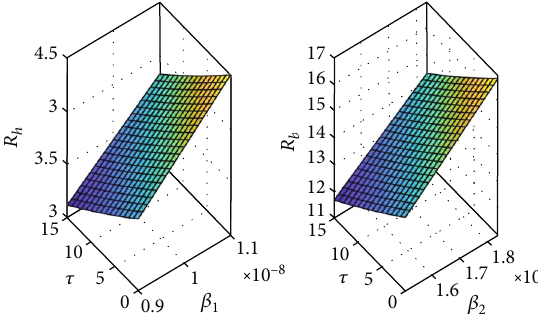
Figure 1: HIV and HBV basic reproduction numbers with varying infection rates ( β , β ) and latency period τ 1 2